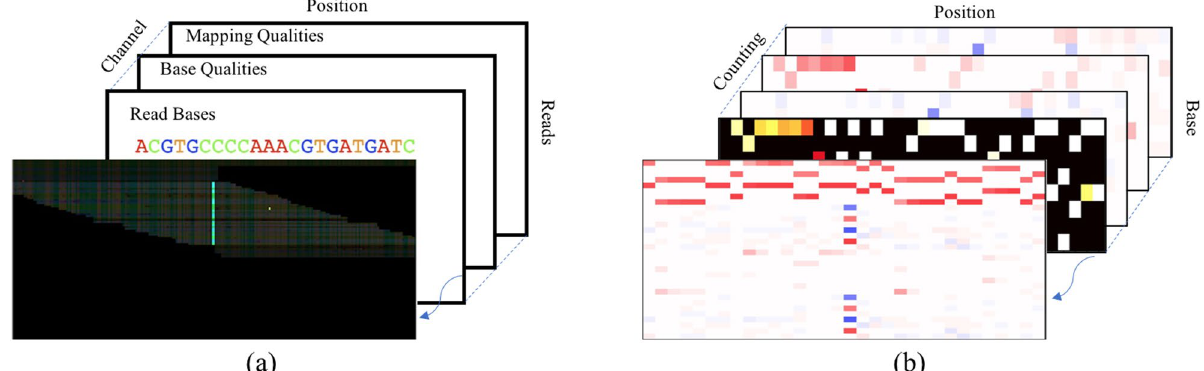
Figure 2. Illustration of input pileup images for two typical methods. ( a ) is for the DeepVariant, and (b) is for the Clair. The front images of (a) and (b) are reconstructed from the rest slices. (a) is a color image of size 200 × 100 with multiple channels, e.g., read base, base quality, mapping quality, etc. ( b ) is a three-dimension image of size 33 × 8 × 4 containing four kinds of counting